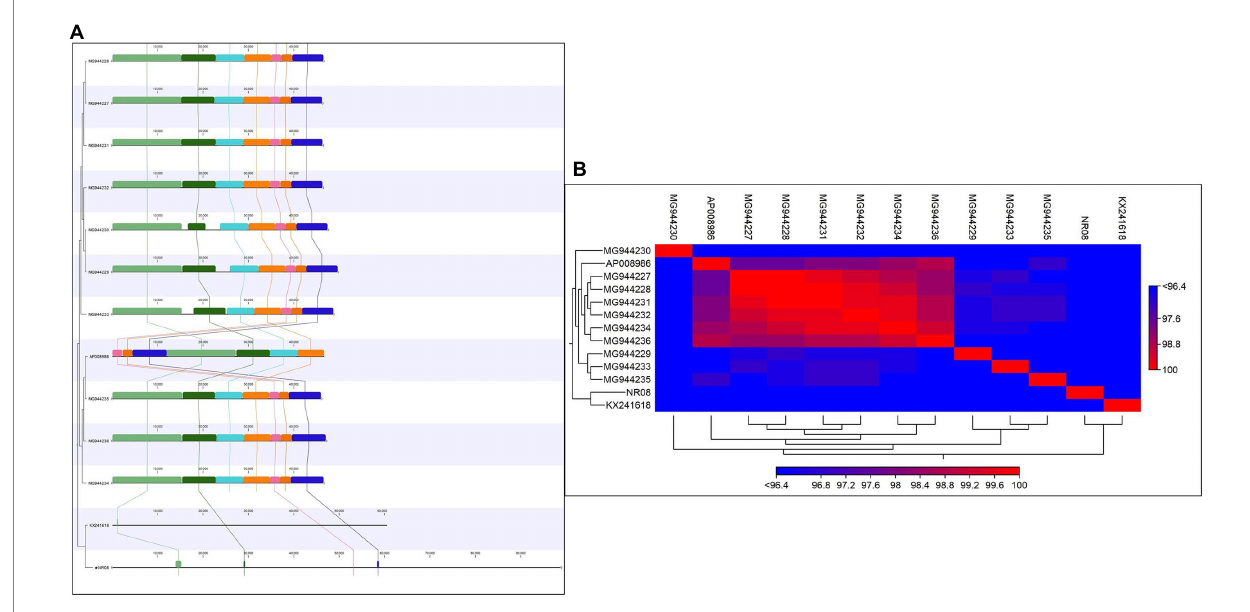
FIGURE 8 (A) Comparative genome analysis of NR08 phage with previously reported 12 Xanthomonas oryzae ( Xoo ) phages. The multicolor domains that appeared in the figure depict the homology in different regions within the whole genome of different phages and their physical positions in